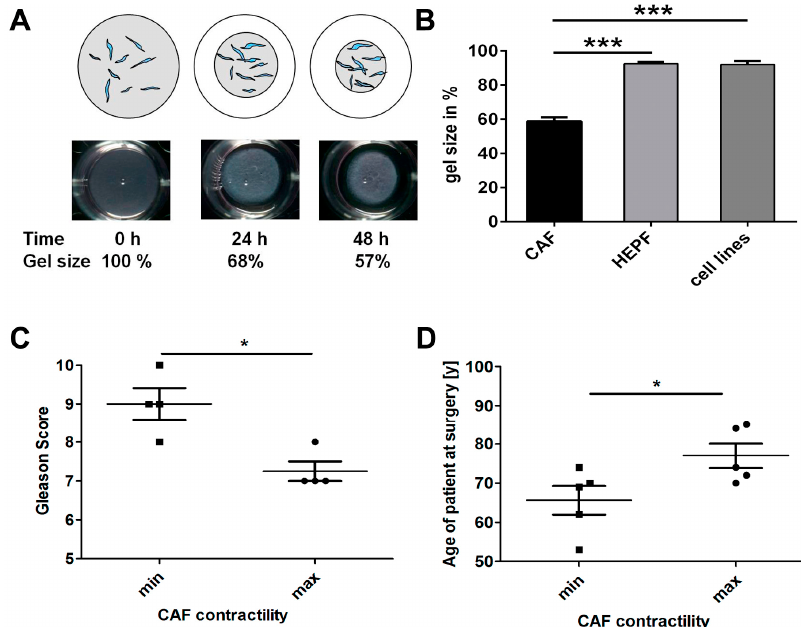
Figure 2. Contractility of CAF in vitro and comparison with Gleason grade and age. ( A ) Top: schematic diagram illustrating the collagen gel contraction (CGC) assay. Fibroblasts were embedded into a collagen matrix (grey) which contracted during culture period followed by measurement and calculation of percentage contraction; Bottom: images of a collagen gel at 0, 24 and 48 h showing a 68%–57% reduction in size; this corresponds to a contractility of 0%, 32% and 43%; ( B ) Comparison of collagen contractility of CAF with human embryonic fibroblasts and fibroblast cell lines after 48 h. CAF ( n = 20 different primary lines) contracted collagen gels while human embryonic prostatic fibroblasts (HEPF) ( n = 4 different primary lines) and fibroblast cell lines (NIH3T3 & WPMY ‐ 1; n = 2) showed significantly less contractility ( p < 0.0001 and p = 0.0002, respectively; unpaired, two ‐